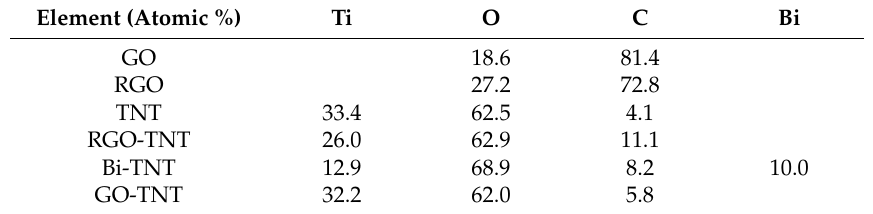
Table 1. The elemental analysis of the AES spectrum of GO, RGO, TNTs and modified TNTs. Element (Atomic %)